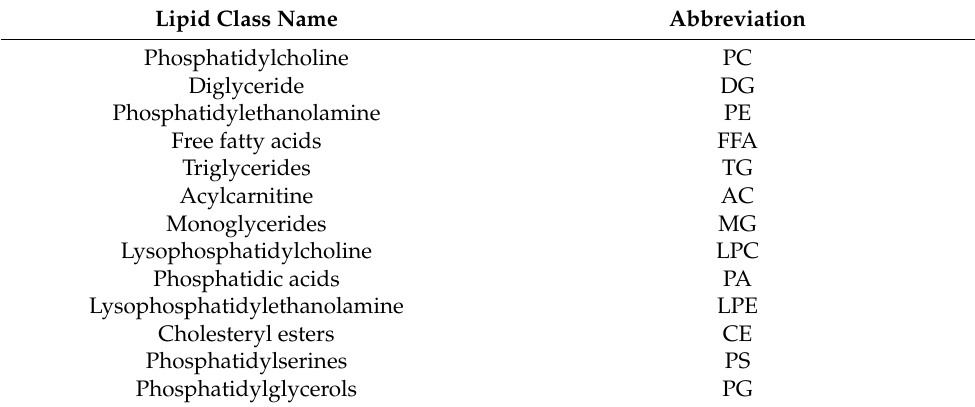
Table 4. Abbreviations for each lipid class found in the Pinot noir wines.